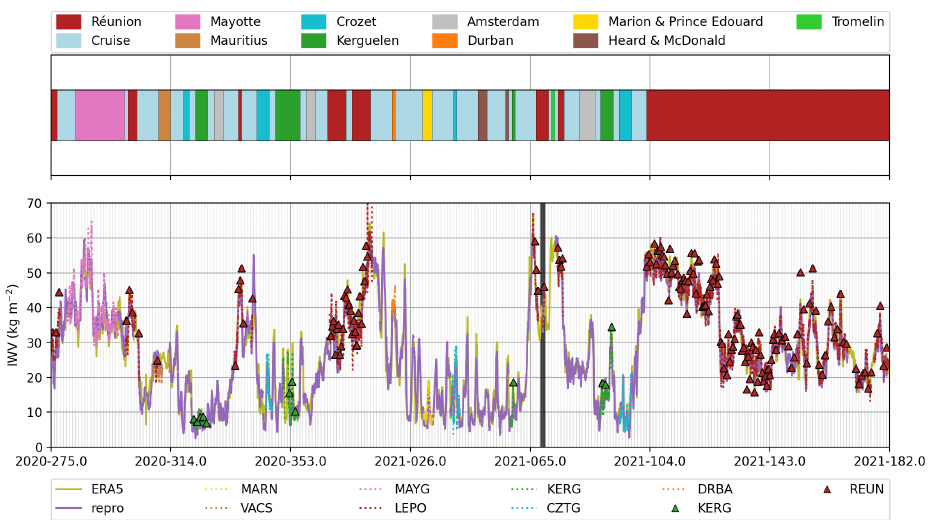
Figure 6. IWV time series along the route of the R/V Marion Dufresne. The upper panel of the figure indicates the location of the R/V Marion Dufresne. The lower panels represent the IWV time series as seen by the Marion Dufresne (purple solid line, repro solution), ERA5 (olive solid line), CORS (dotted lines; MARN, VACS, MAYG, LEPO, KERG, CZTG and DRBA) and radiosondes (triangles, REUN and KERG); the thick vertical black line denotes the change of antenna location on the